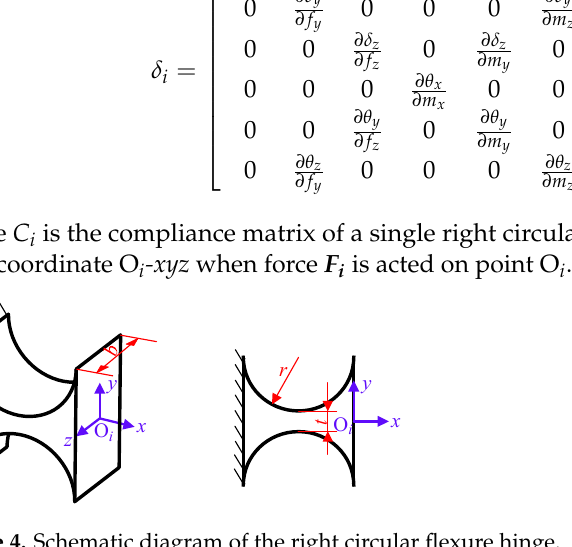
Figure 4. Schematic diagram of the right circular flexure hinge.